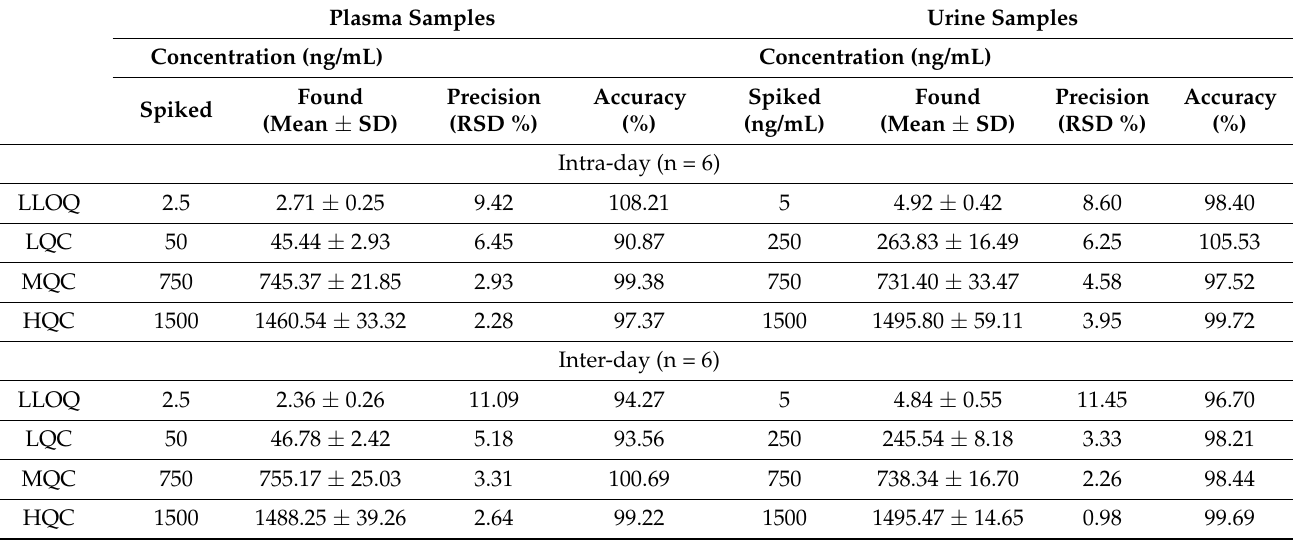
Table 3. Accuracy and precision for the determination of DOC in plasma and urine samples (n = 6). Plasma